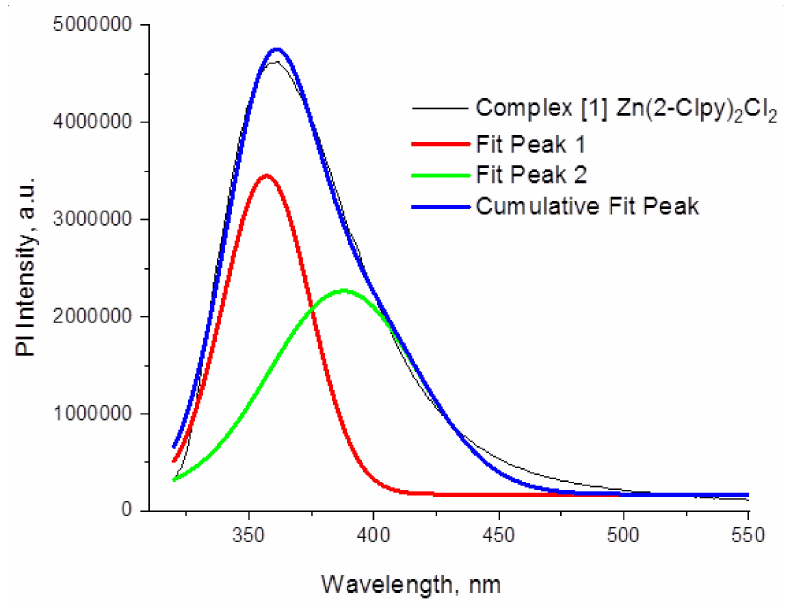
Figure 5. Emission spectra of 1 and its decomposition on two and three Gauss components, T = 298 K, λ ex = 350 nm. Gauss fit was performed in eV scale and then spectra were reported in nm scale. Conversion between eV and nm scales was performed with account of λ 2 factor [61]. Table 4. Isostructural complexes of [(2-XL) 2 MY 2 ]